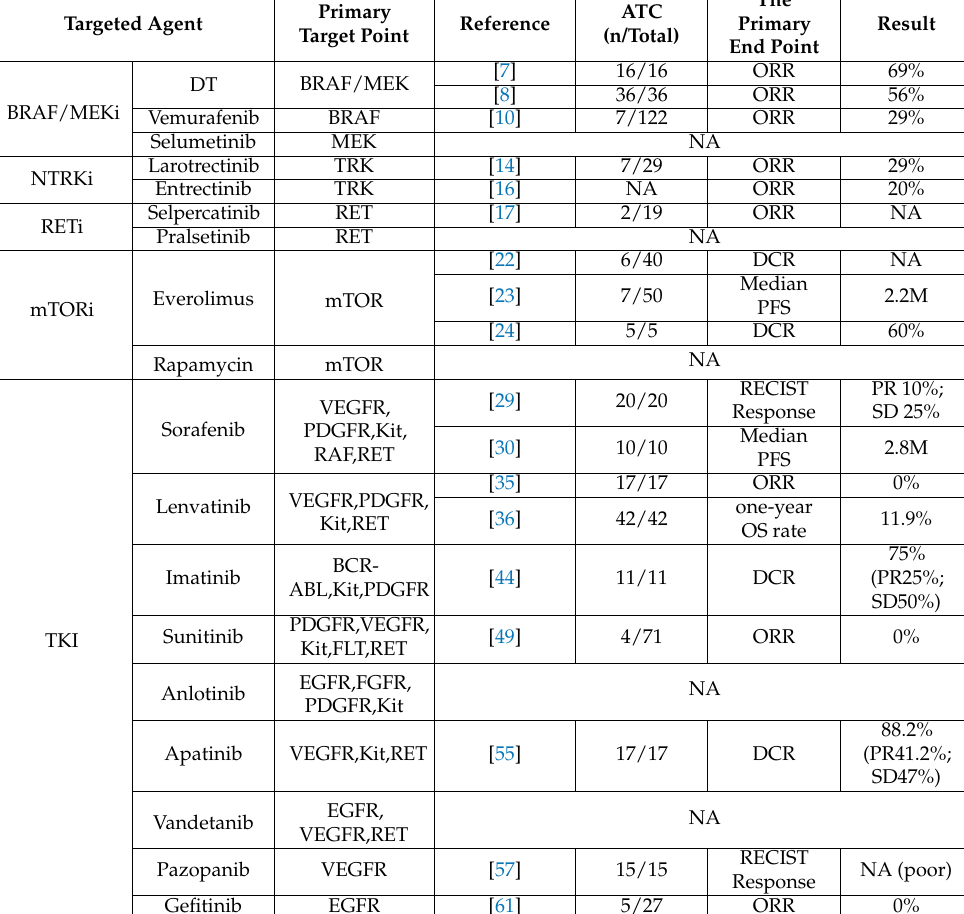
Table 4. Primary target points and summary of clinical trials of targeted agents